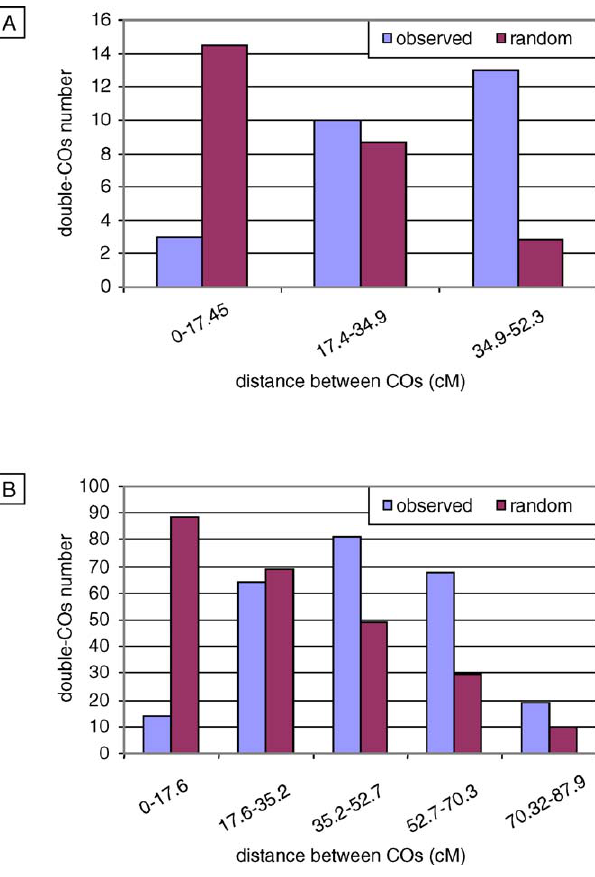
Figure 5. Distributions of Inter-CO Distances on Chromosome 4 Observed (blue) and random (purple) distributions of inter-CO distances in (A) F and (B) M populations.